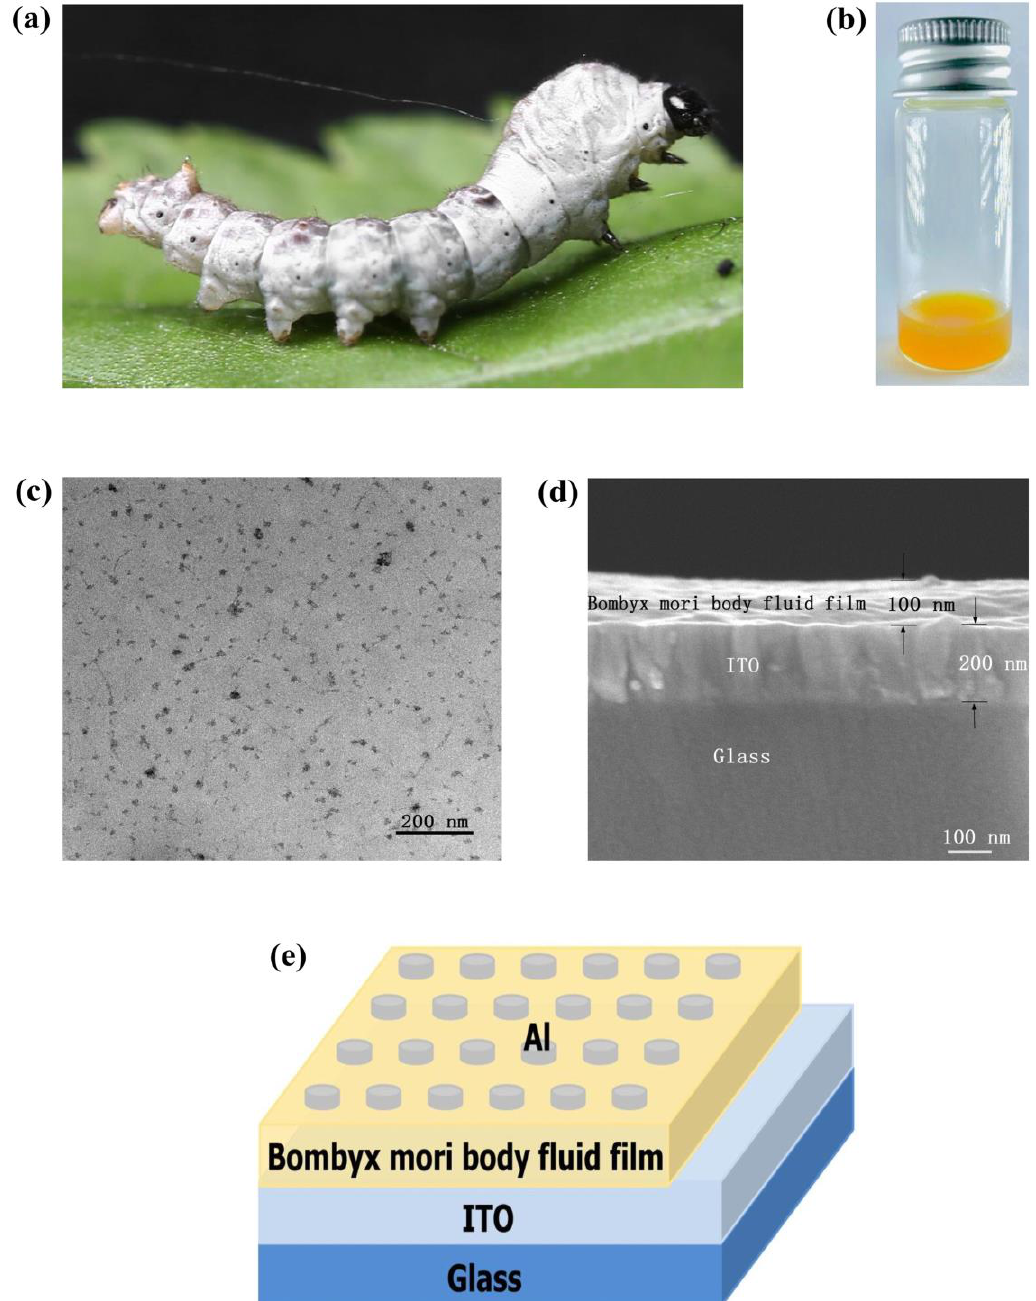
Figure 1. ( a ) Photograph of a Bombyx mori ; ( b ) Photograph of Bombyx mori body fluid; ( c ) TEM image of Bombyx mori body fluid; ( d ) SEM image of the cross section of the Bombyx mori body fluid film/indium tin oxide (ITO)/glass structure; ( e ) Schematic diagram of the Al/ Bombyx mori body fluid film/ITO biomemristor.